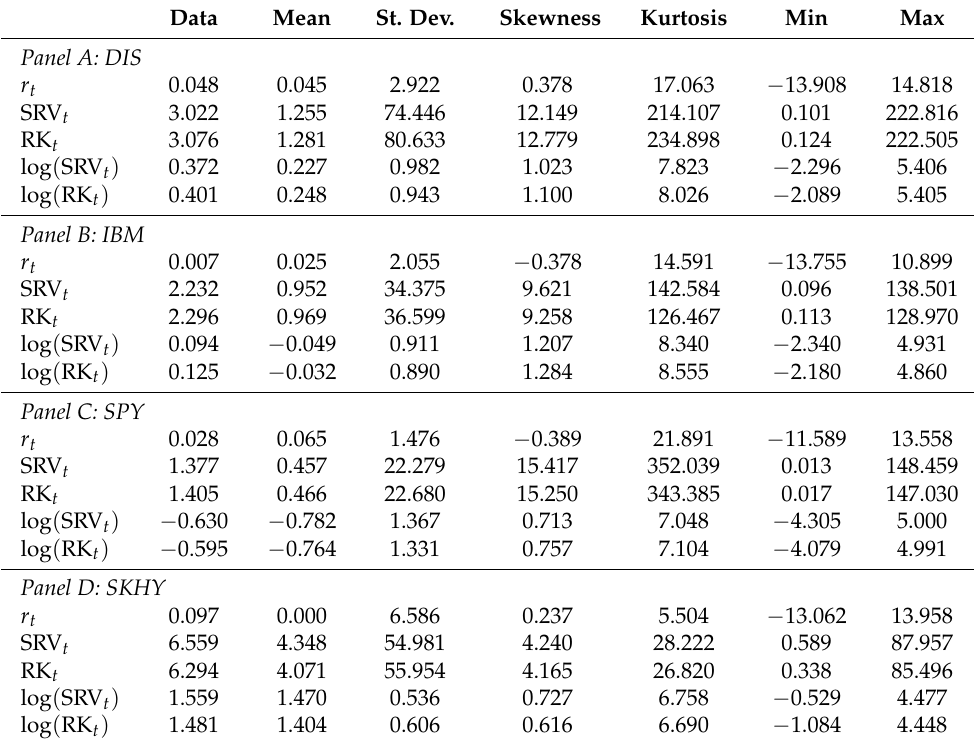
Table 1. Descriptive statistics for returns and volatility measures of DIS, IBM, SPY and SKHY. Data Mean St.